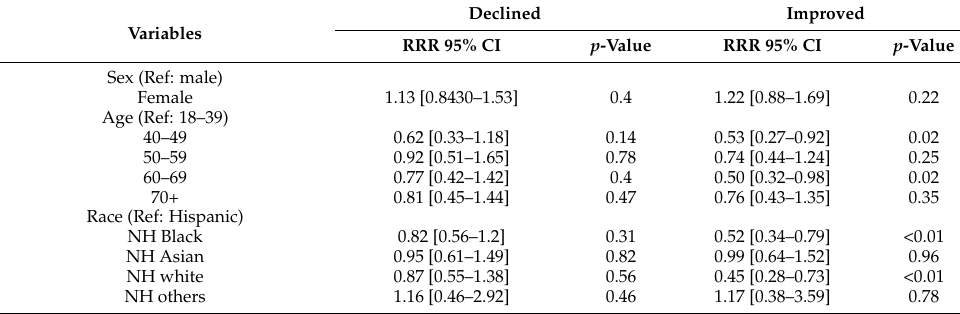
Table 3. Factors affecting mental HRQOL of diabetes